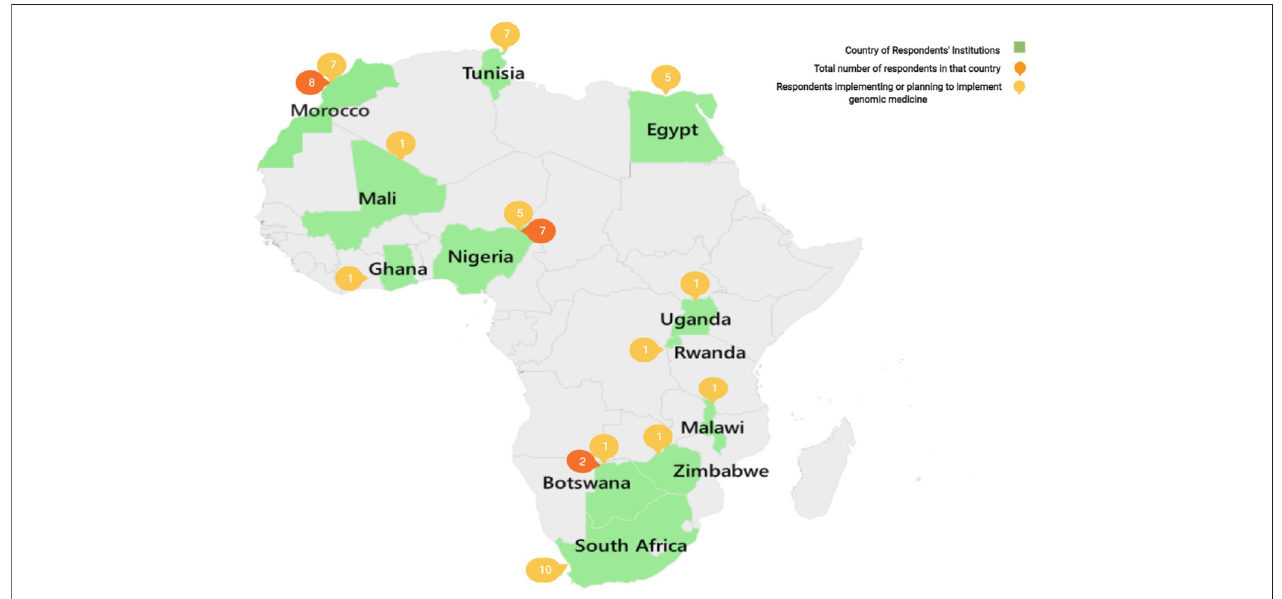
FIGURE1| Mapshowingthecountriesfromwhichresponseswerereceived,includingthetotalnumberofrespondentswithinthecountry(darkorange)andoutof these, the number who are currently or planning to implement genomic medicine activities (light orange).